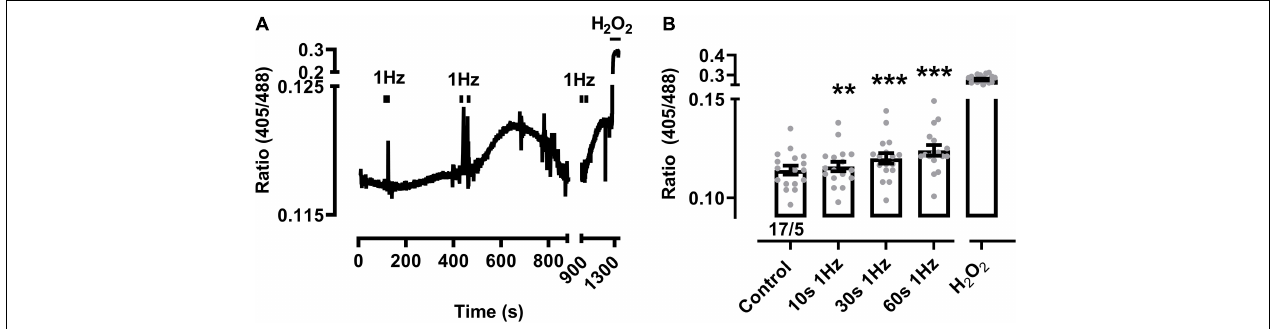
FIGURE 2 | Mitochondrial oxidation following prolonged 1 Hz beating in sTG-cardiomyocytes. (A) Representative time course of the redox biosensor I405/I488 nm ratio with pacing-evoked 1 Hz beating trains in a mito-Grx1-roGFP2 cardiomyocyte. Black bars indicate the start and end of each beating interval lasting 10, 30, and 60 s, respectively. H 2 O 2 (200 µ M) was added at the end of the experiment as indicated to confirm the maximal level of mitochondrial oxidation. The interval between 900 and 1,300 s was condensed to show the reversible signal changes after 30 s pacing. (B) Dot-bar plot showing the I405/I488 nm ratio of the individual cardiomyocytes and mean values ± SEM. Measurements were obtained under baseline conditions and following EFS-pacing at 1 Hz for the indicated beating durations. Cell/heart numbers are indicated. Paired one-way ANOVA with Dunnett’s post-test. ** P = 0.007; *** P < 0.001.